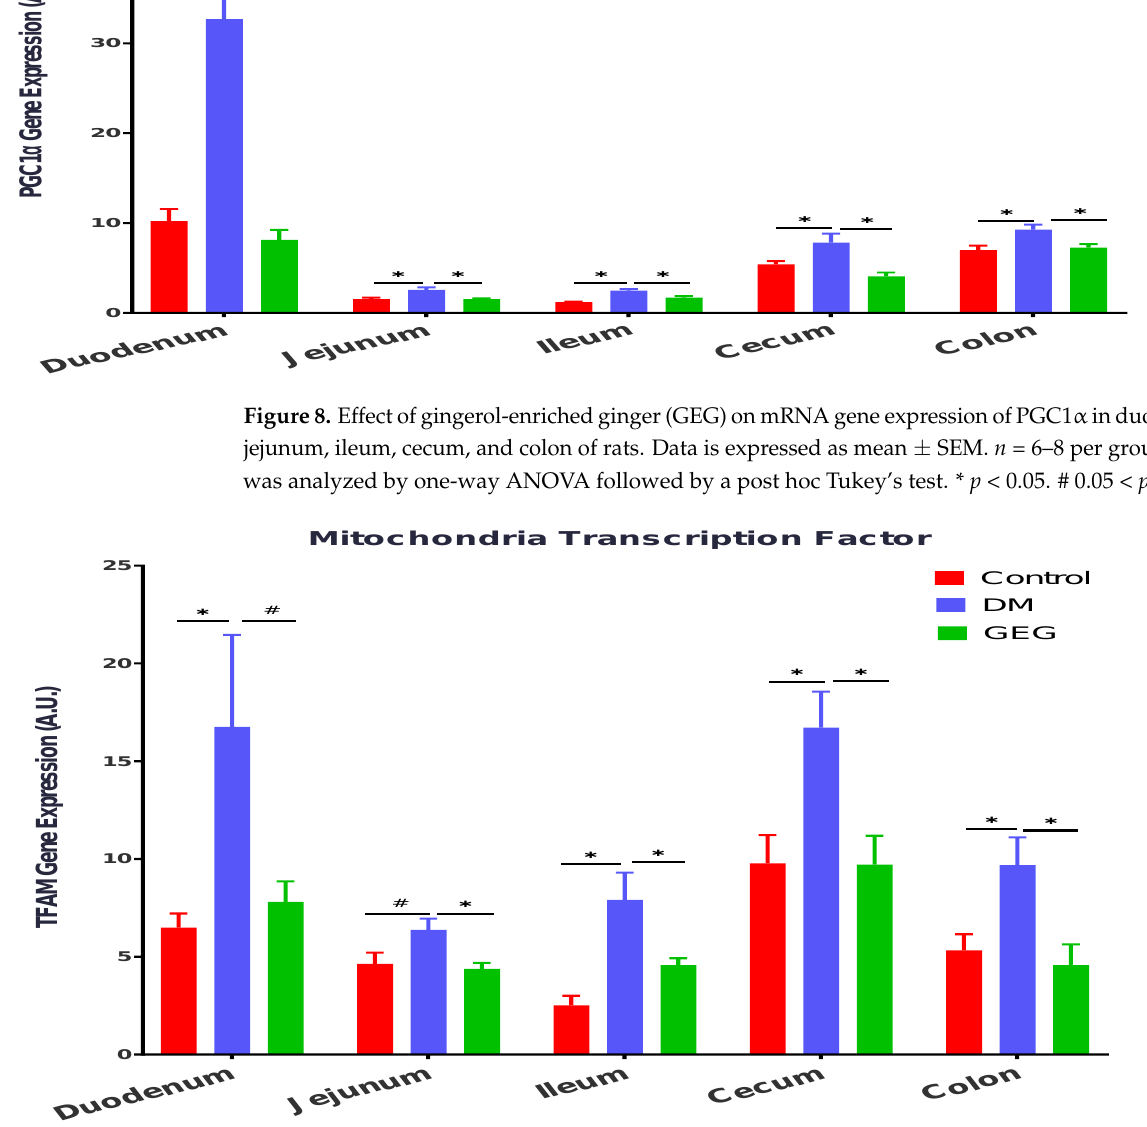
Figure 9. Effect of gingerol-enriched ginger (GEG) on mRNA gene expression of TFAM in duodenum, jejunum, ileum, cecum, and colon of rats. Data is expressed as mean ± SEM. n = 6–8 per group. Data was analyzed by one-way ANOVA followed by a post hoc Tukey’s test. * p < 0.05. # 0.05 < p < 0.1.